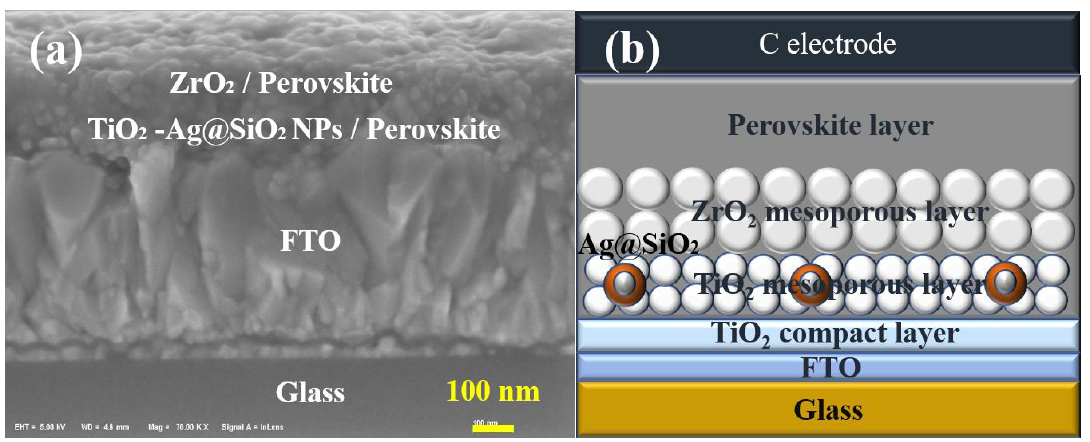
Figure 4. ( a ) Scanning Electron Microscope (SEM) image of a cross section of a complete PSC mixed with Ag@SiO 2 NPs; ( b ) Structural representation of a whole PSC device mixed with Ag@SiO 2